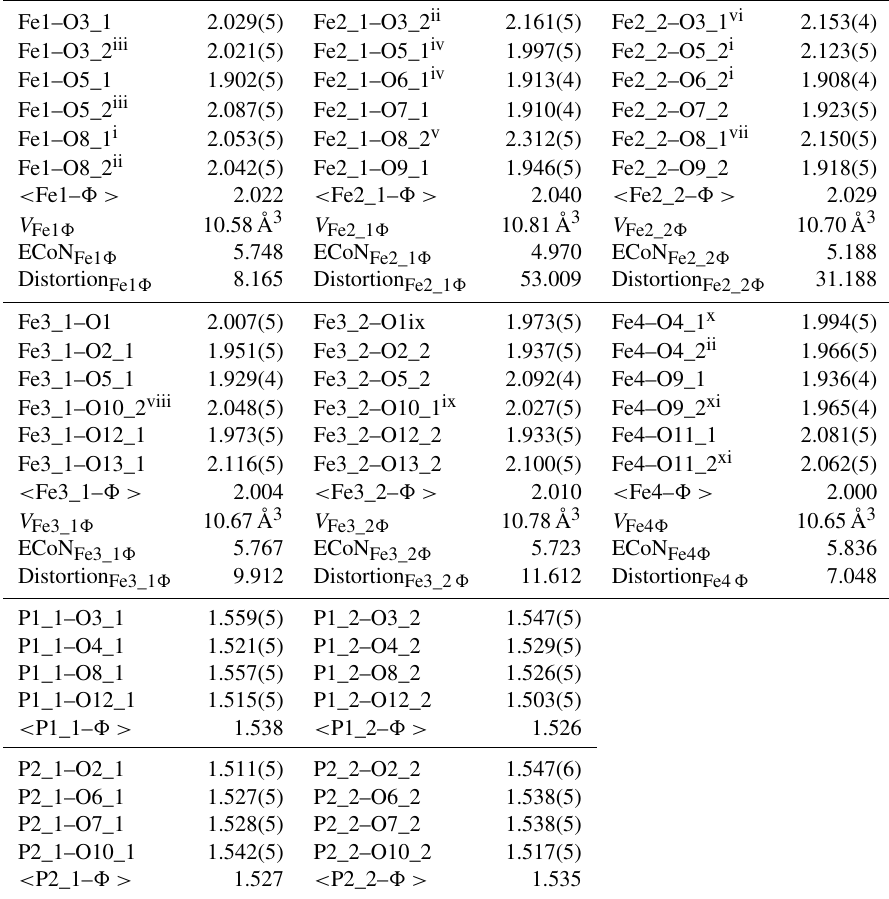
Table 7. Selected interatomic distances (Å) and polyhedral measures for